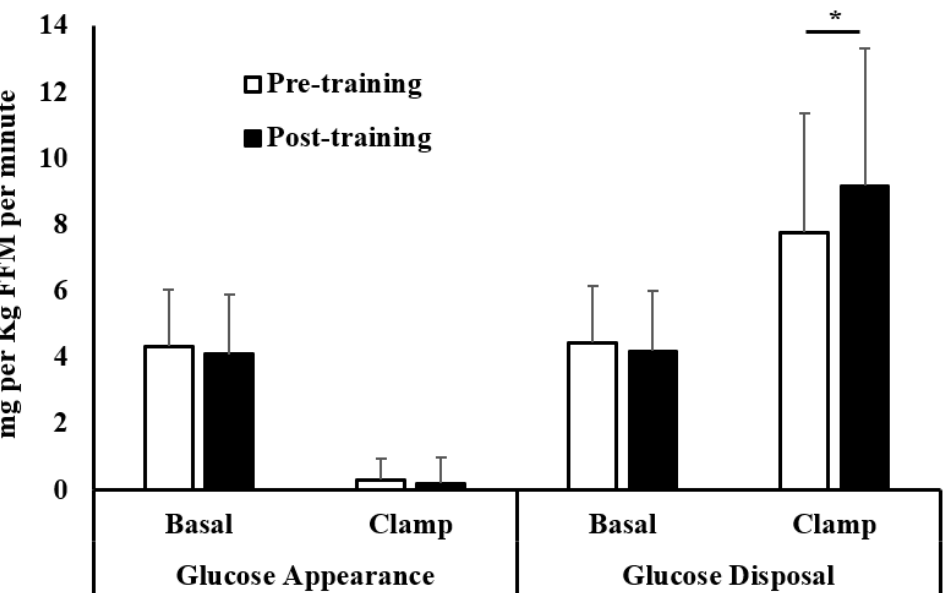
Figure 2. Basal and insulin-stimulated (clamp) rates of endogenous glucose appearance and glucose disposal determined using 6,6 di-deuterated glucose in the pre- versus post-training. Data are mean ± SD and expressed as mg per Kg FFM per minute. * p < 0.01, paired Student’s t -test. Rates of glucose appearance were similar pre- versus post-training basally (pre: 4.3 ± 1.7 versus post: 4.1 ± 1.8 mg per Kg FFM per minute, p = NS) and after insulin stimulation